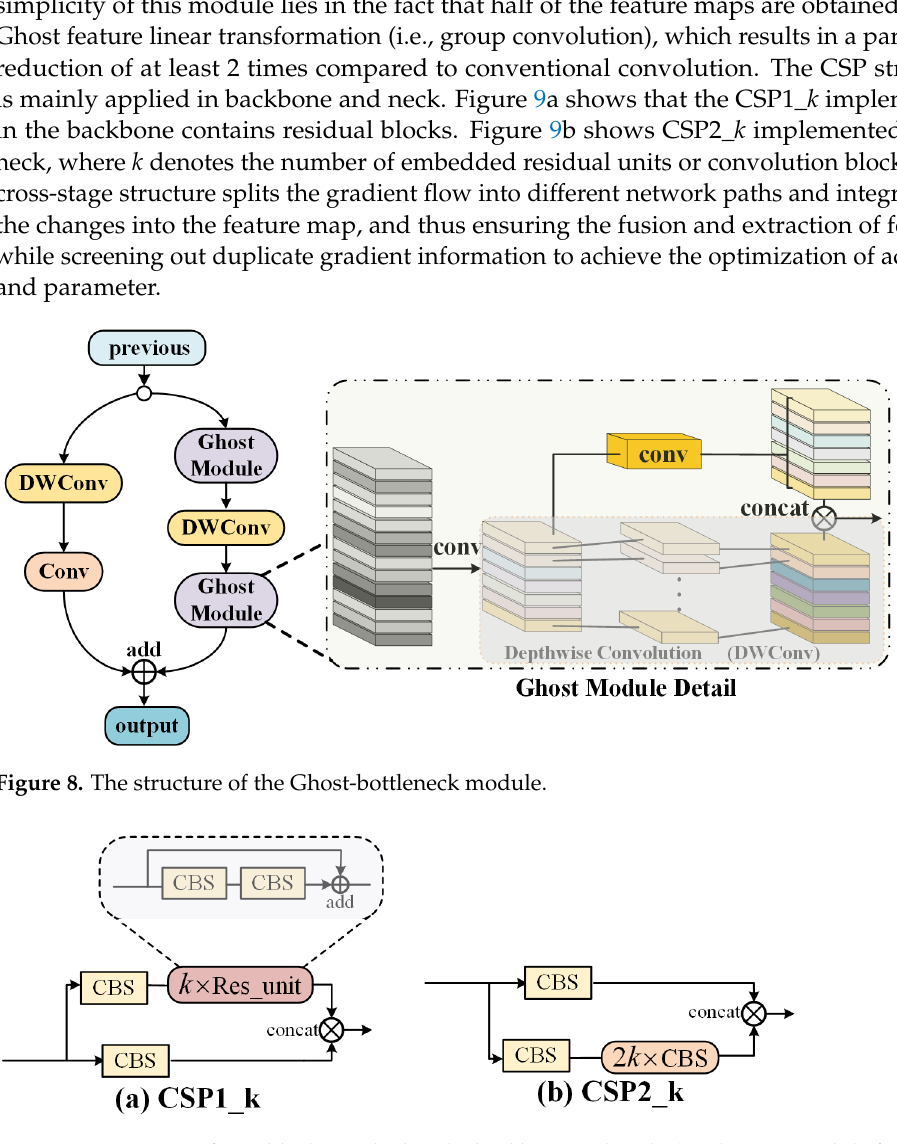
Figure 9. Two types of CSP blocks applied in the backbone and neck. ( a ) The CSP module for feature extraction in backbone networks ( b ) The CSP module for feature enhancement applied in the Neck of Network.